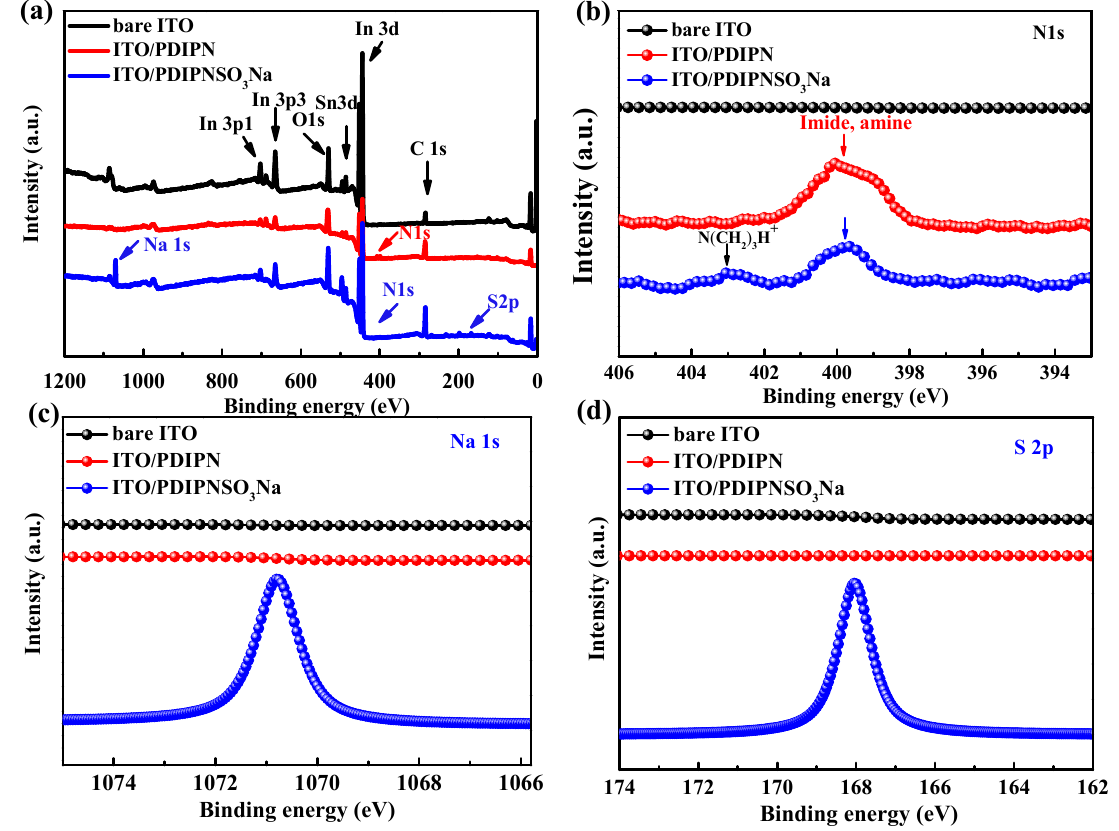
Figure 3. ( a ) Survey X-ray photoelectron spectra of bare ITO, ITO/ PDIPN and ITO/ PDIPNSO 3 Na ( b ) N 1s, ( c ) Na 1s, ( d ) S 2p.